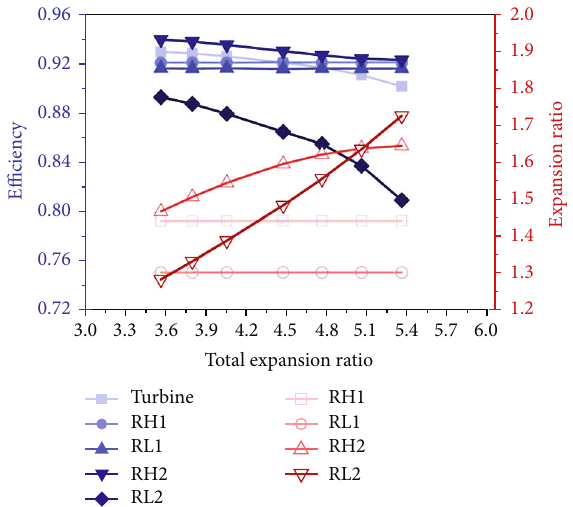
Figure 13: E ffi ciency and expansion ratio distribution.